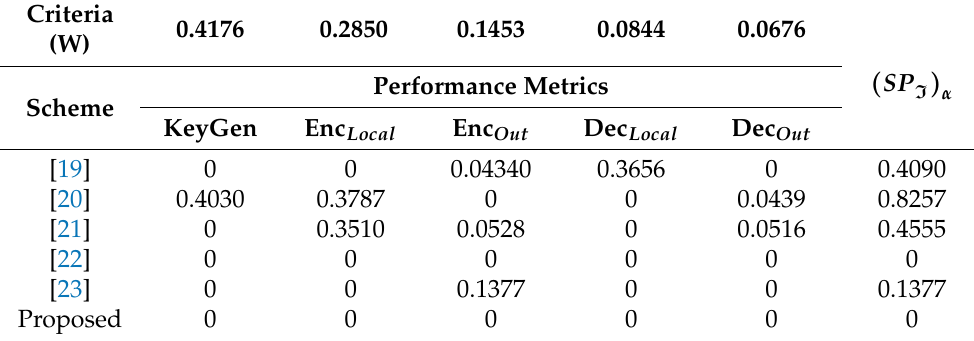
Table 10. Analysis results of the aggregate ( N I )